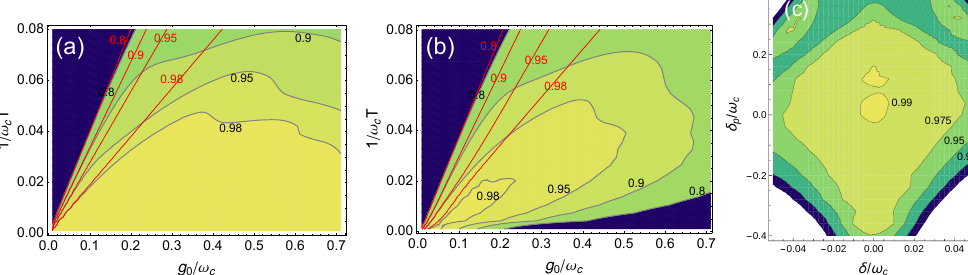
Figure 1. ( a ) Efficiency of population transfer P | 0 eg (cid:105) ( t f ) in the N = 1 manifold for Rabi model and for the RWA (straight lines) for κ = 0. ( b ) The same for κ = 0.005, showing a region around g / ω c = 0.15 where one may take advantage of the ultrastrong coupling, while at larger g combination of DCE and decay spoil the efficiency. ( c ) Sensitivity of population transfer to detunings, showing that the protocol is robust against fluctuations in a wide region about the resonance point δ = δ p = 0, and that positive single photon detuning δ p > 0 may further increase the efficiency.